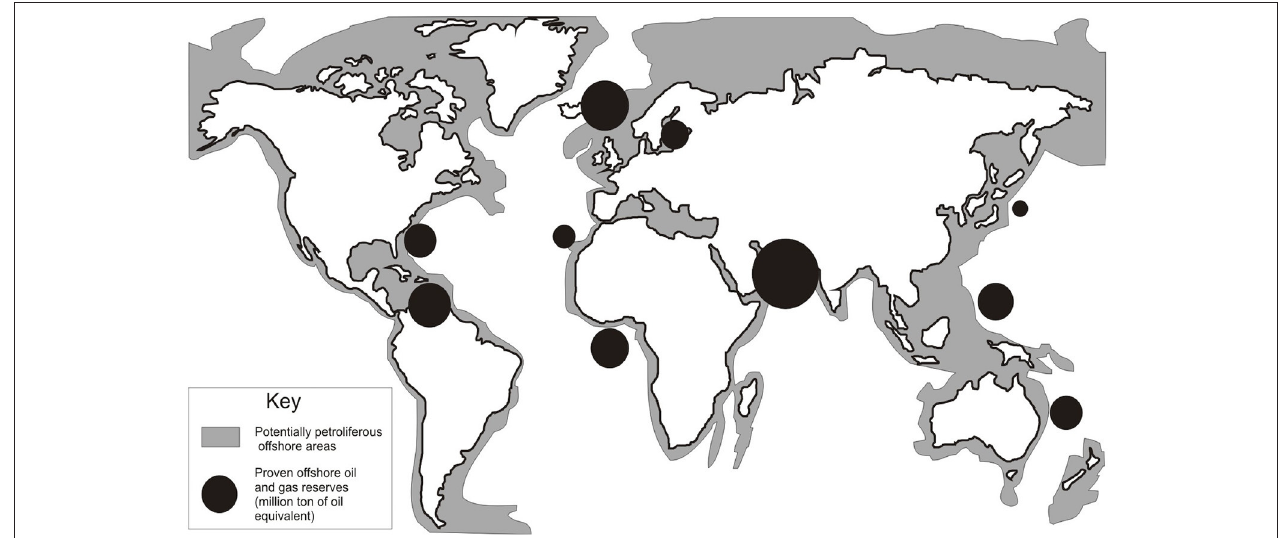
FIGURE 1 | Potentially petroliferous offshore zones and regional distribution of proven offshore oil and gas reserves. Adapted from Pinder